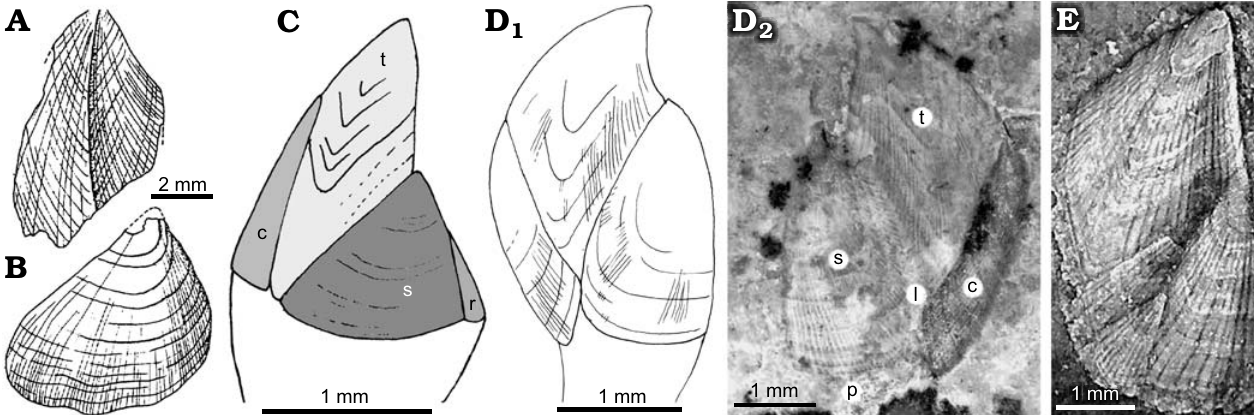
Fig. 2. Fossil taxa assigned to Neolepadidae. A , B . ? Neolepas augurata Buckeridge and Grant-Mackie, 1885 (original of Buckeridge and Grant-Mackie 1985: figs. 2, 3); Sinemurian–Pliensbachian (Lower Jurassic), New Caledonia. A . University of Auckland Geology Department UoA A291a, b, external mould of tergum. B . University of Auckland Geology Department UoA A292a, b, external mould of scutum. This is here tentatively interpreted as an eolepadid. C . Toarcolepas mutans Gale and Schweigert, 2015 (SMNS 26029); Toarcian (Jurassic), Harpoceras falciferum Zone, Zell u. Aichelberg, Ger- many; reconstruction based upon type material (Gale and Schweigert 2015: fig. 5). D . Litholepas klausreschi Nagler, Haug, Glenner, and Buckeridge, 2017; Tithonian (Upper Jurassic), Hybernoticeras hybernotum Zone, Eichstatt, Germany; D 2 , SMNS 70388/5 (decolourised original of Nagler et al. 2017: fig. 5B). I am unable to identify the upper latus, marked “l” in their figure; D 1 , reconstruction (mirrored for comparison with C). E . Con cinnalepas